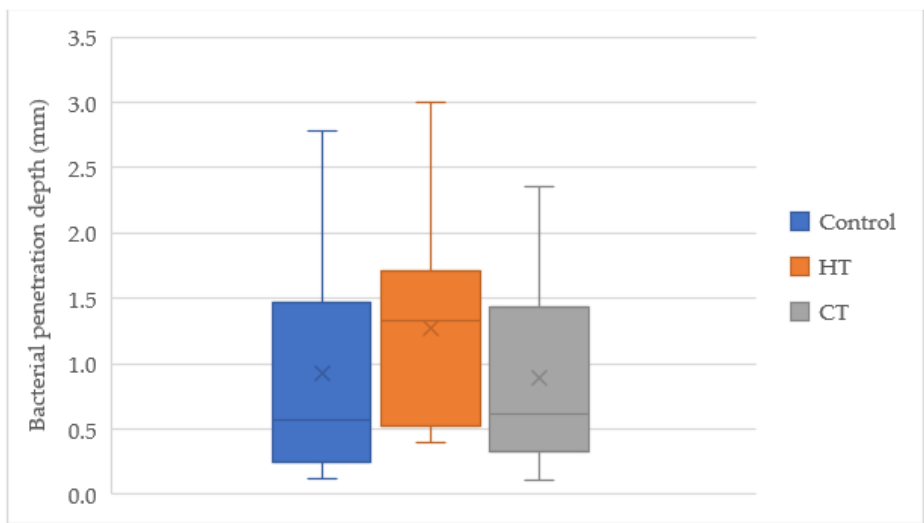
Figure 6. Distance (mm) between the bacterial load in the crown area and the pulp chamber. p = 0.0167. Abbreviations: CT, conventional technique HT, Hall technique; M + D, mesial and distal.